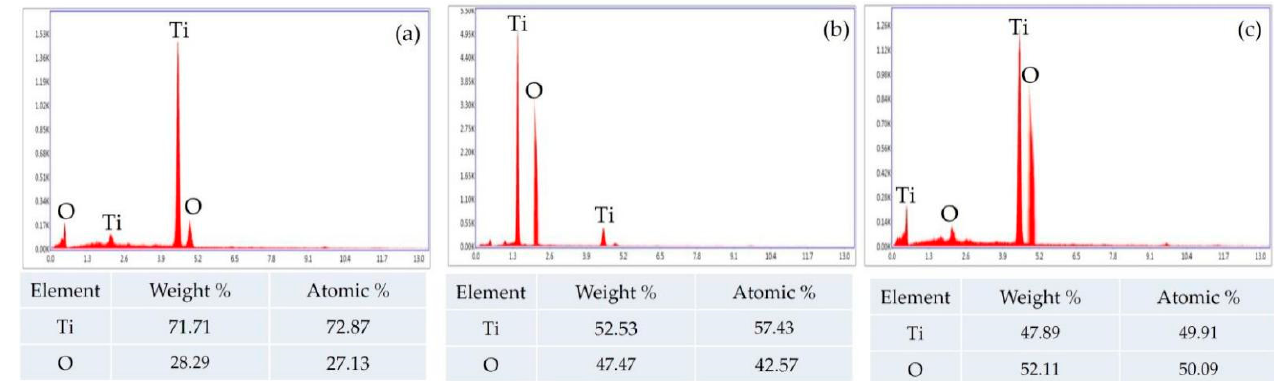
Figure 11. EDX images of different sizes of TiO 2 NPs attained from ( a ) Bacillus subtilis [79], ( b ) Cassia fistula , and ( c ) hydrothermal heating [80].